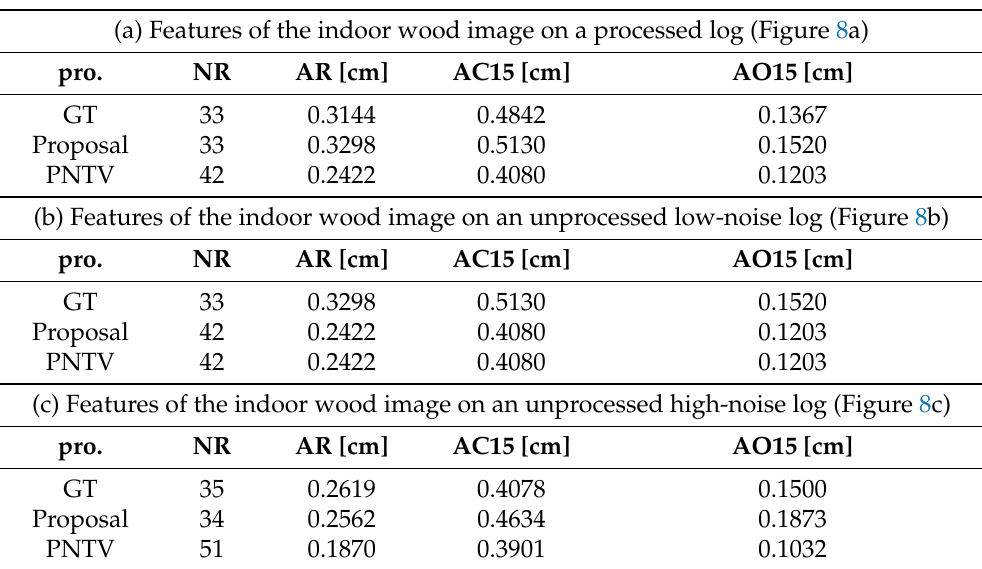
Table 1. Features of indoor wood